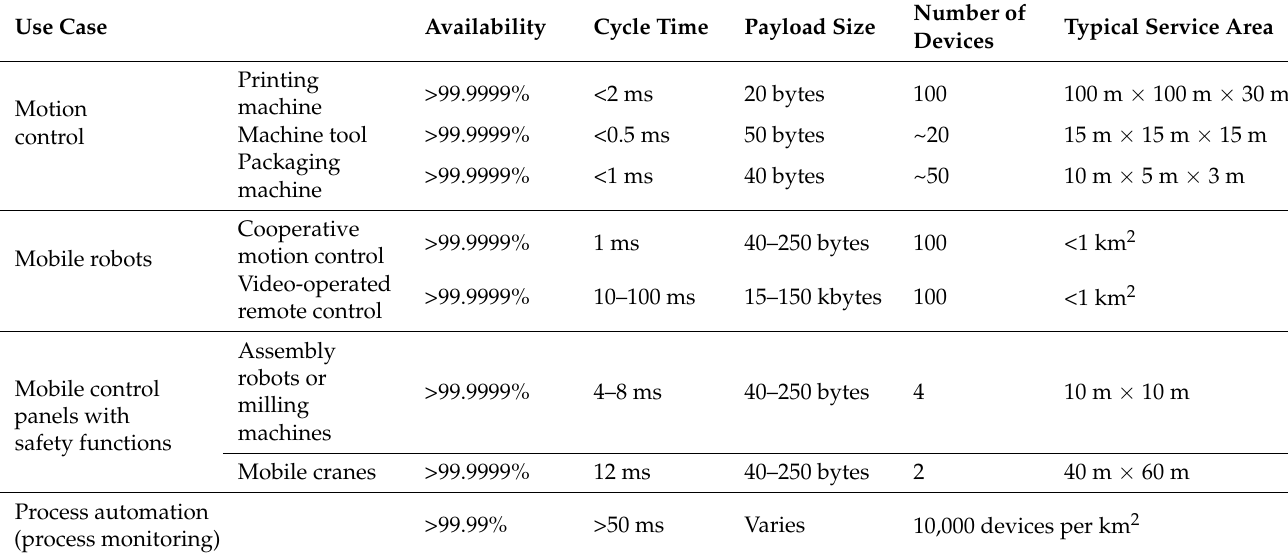
Table 1. Comparison of peak data rate versus latency